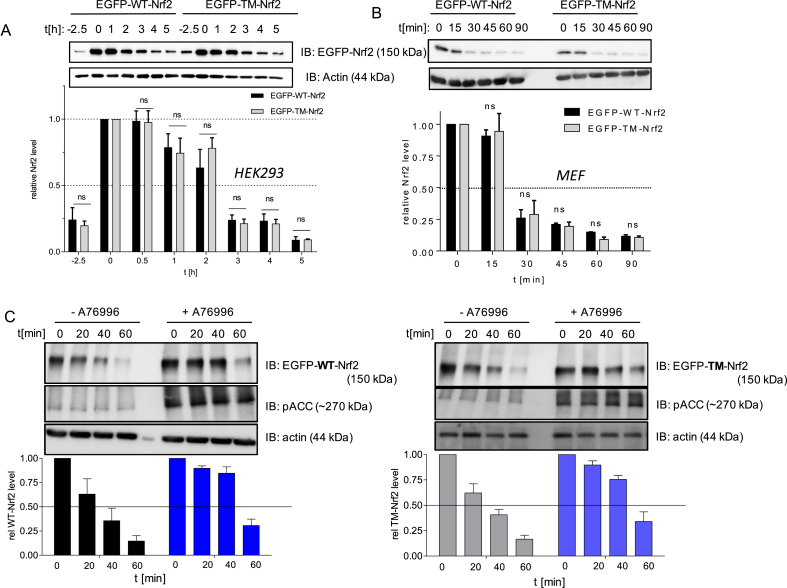
The identified AMPK-dependent phosphosites in Nrf2 do not markedly influence half-life of Nrf2 in wt cells. (A) HEK293 were transfected with EGFP-tagged WT or TM-Nrf2 expression plasmids and treated with MG132 (20 μM) for 2.5 h (t = −2.5 to 0) to accumulate Nrf2. After washout of MG132 the translation inhibitor cycloheximide (100 μM) was added (time point 0) for another incubation period of 1–5 h as indicated. Cell lysates were subjected to immunoblot analysis for EGFP-Nrf2 (via α-GFP antibody) or actin. Representative blot and compiled densitometric evaluations (below) for EGFP-Nrf2/actin (related to signal at t = 0) are depicted. (n ≥ 3, mean +SD, unpaired Student's t-test, two tailed, α = 0.05, *P < 0.05, ns: not significant). (B) Wt MEF were transfected with EGFP-tagged WT or TM-Nrf2 expression plasmids and treated with MG132 (10 μM) for 1 h to accumulate Nrf2. After washout, cycloheximide (30 μM) was added (time point 0) for the indicated periods of time. Cell lysates were subjected to immunoblot analysis for EGFP-Nrf2 (via α-GFP antibody) or actin. Representative blots and compiled densitometric evaluations (below) for EGFP-Nrf2/actin (related to signal at t = 0) are depicted. (n = 3, mean +SD, unpaired Student's t-test, two tailed, α = 0.05, *P < 0.05, ns: not significant).(C) Wt MEF were transfected with EGFP-tagged WT- or TM-Nrf2 expression plasmids and treated with MG132 (10 μM) and DMSO or A769662 (50 μM) for 1 h. After washout of MG132 the translation inhibitor cycloheximid (30 μM) was added (time point 0) in the presence of A769662 (50 μM) (+) or DMSO (−) for the indicated period of time. Cell lysates were subjected to immunoblot analysis for EGFP, pACC or actin. Representative blots and compiled densitometric evaluations for DMSO and A769662-treated cells (EGFP-WT- or EGFP-TM-Nrf2/actin, related to signal at t = 0) are depicted (n = 3, mean +SD).